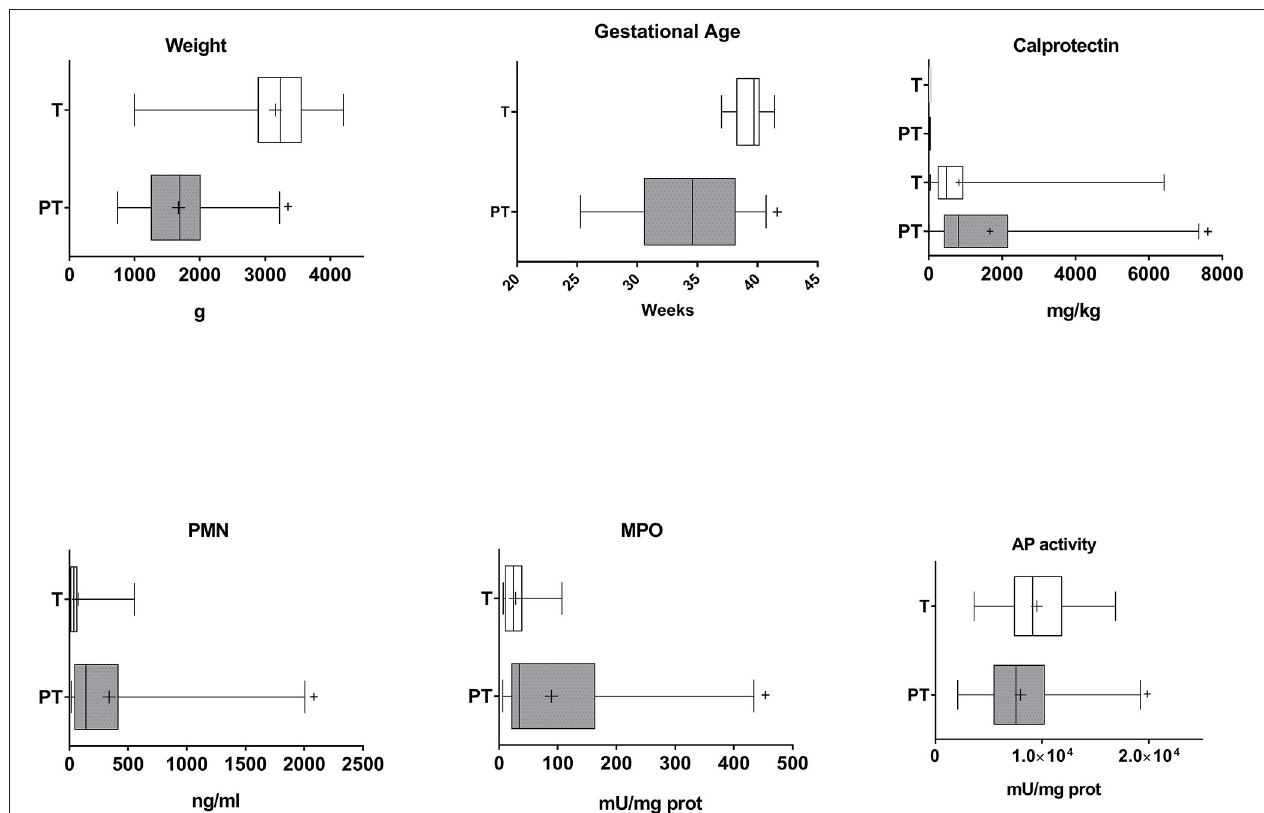
FIGURE 1 | Gestational age, birth weight, and inflammatory markers in the meconium of T and PT infants. Birth weight and gestational age of the newborns and calprotectin, PMN-E, MPO, and AP activity in the feces are shown. + p < 0.05 vs. T.